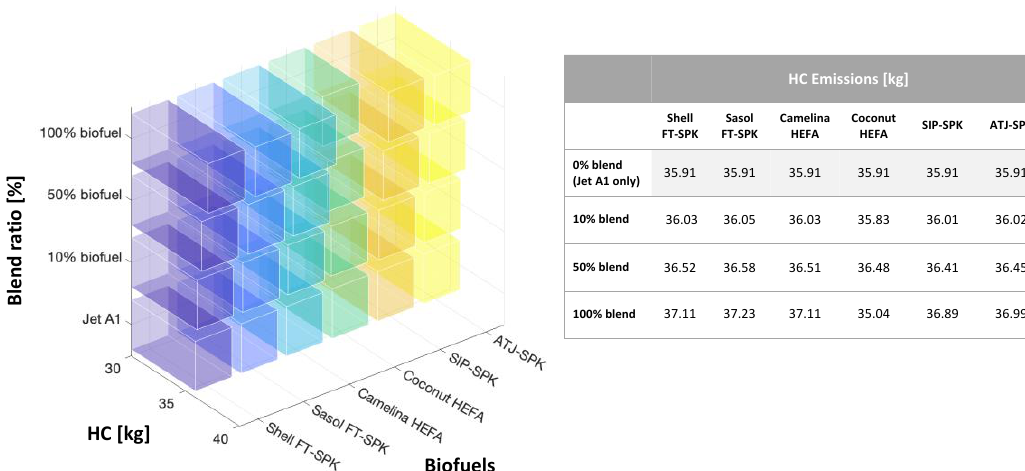
Figure 13. CO overall emissions along the reference Concorde mission, with the impact of different biofuels and blending ratios.